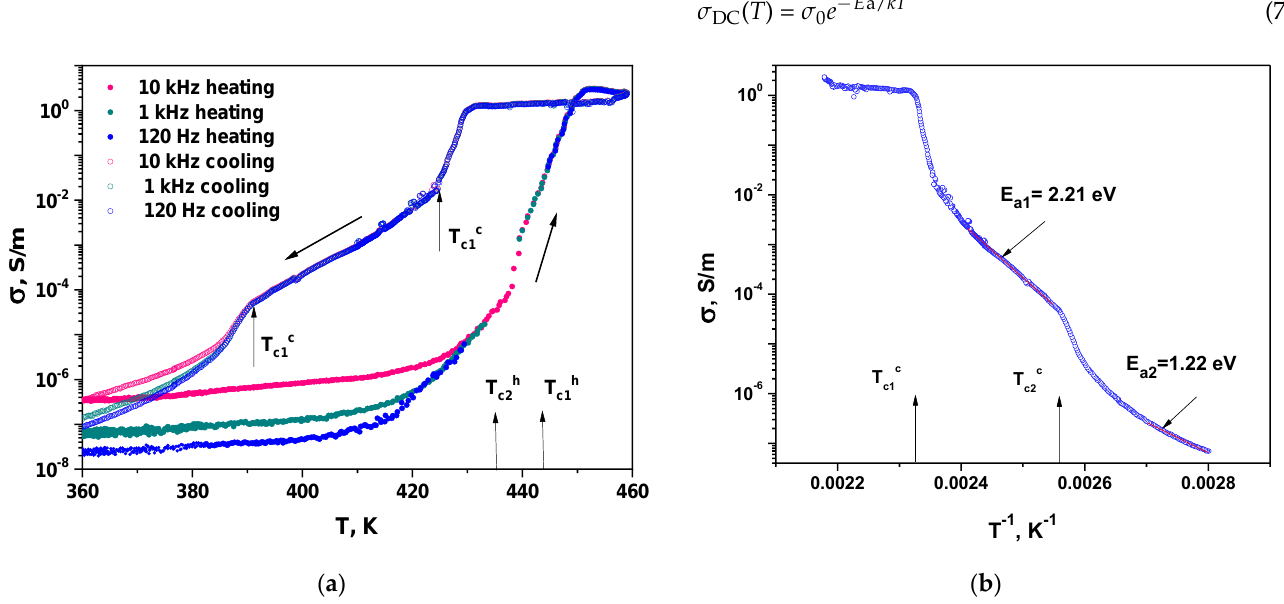
Figure 12. Temperature dependence of conductivity σ during heating–cooling cycle in semilogarith- mic scale for different frequencies ( a ). Dependence of σ at f = 120 Hz on reversed temperature T − 1 in semi-logarithmic scale ( b ).